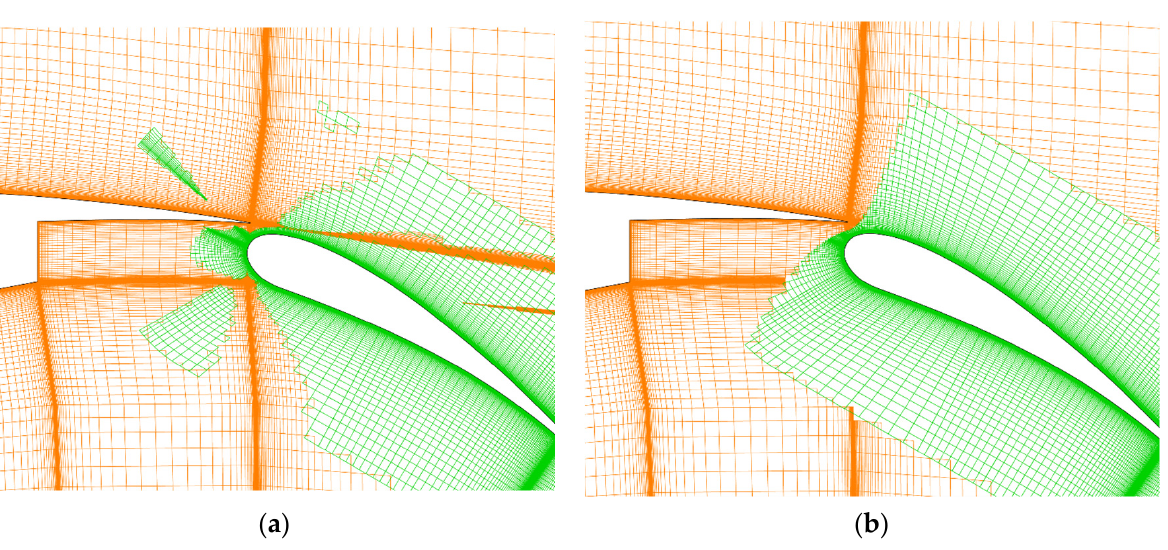
Figure 1. Pre-classification results of the original criterion and ROAT: ( a ) result of the Löhner criterion; ( b ) result of the ROAT.